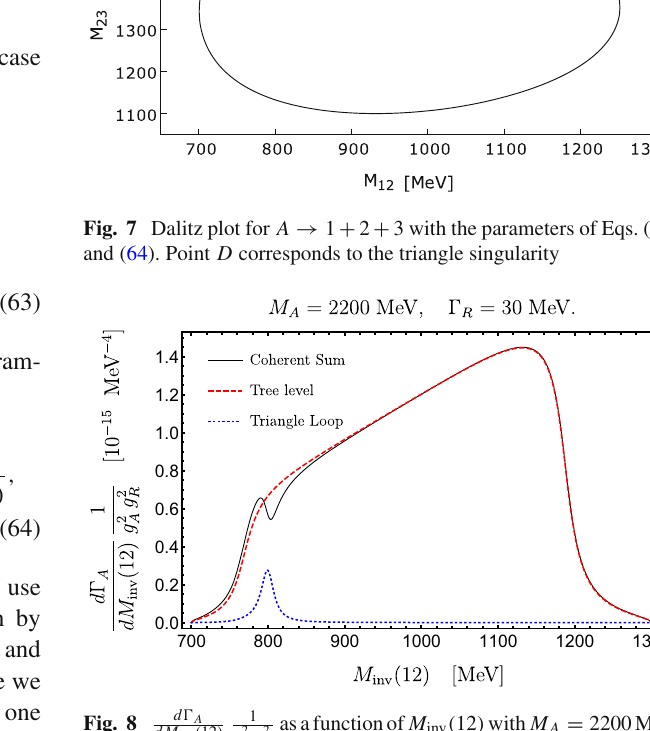
1 Fig. 8 d (cid:4) A asafunctionof M inv ( 12 ) with M A = 2200MeV dM inv ( 12 ) g 2 A g 2 R and (cid:4) R = 30